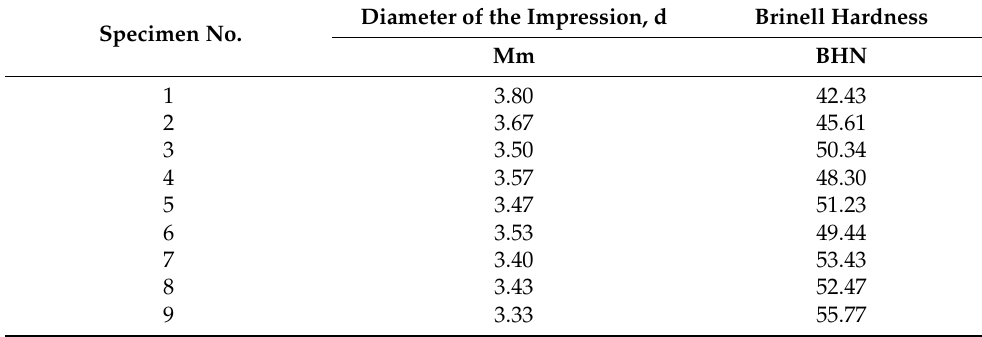
Table 6. Hardness test